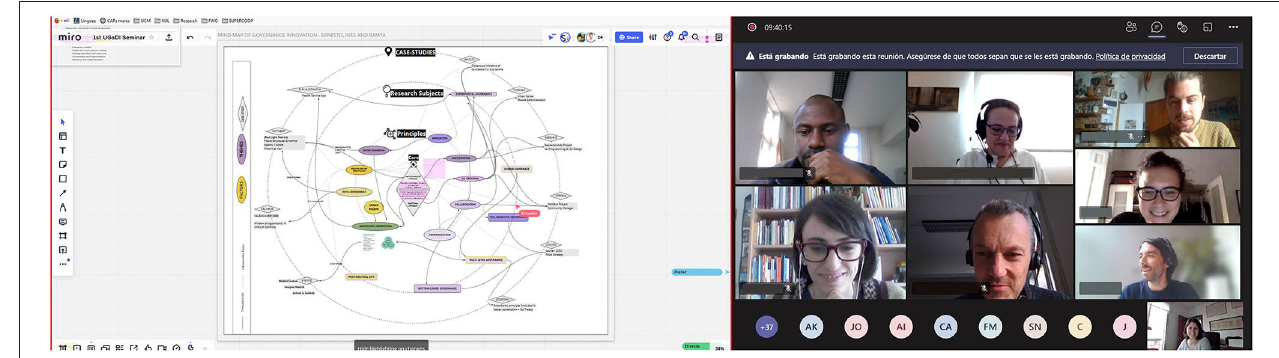
FIGURE 6 | Screenshot during the UGADI Seminar Plenary session sharing the collective outcomes produced about governance innovation research.